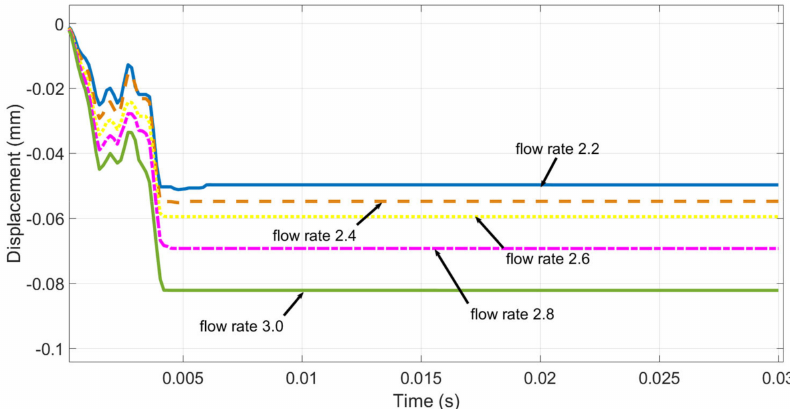
Figure 4. Displacement changing graph of sensor characteristic point C in X direction under the impacts of different momentum jets.